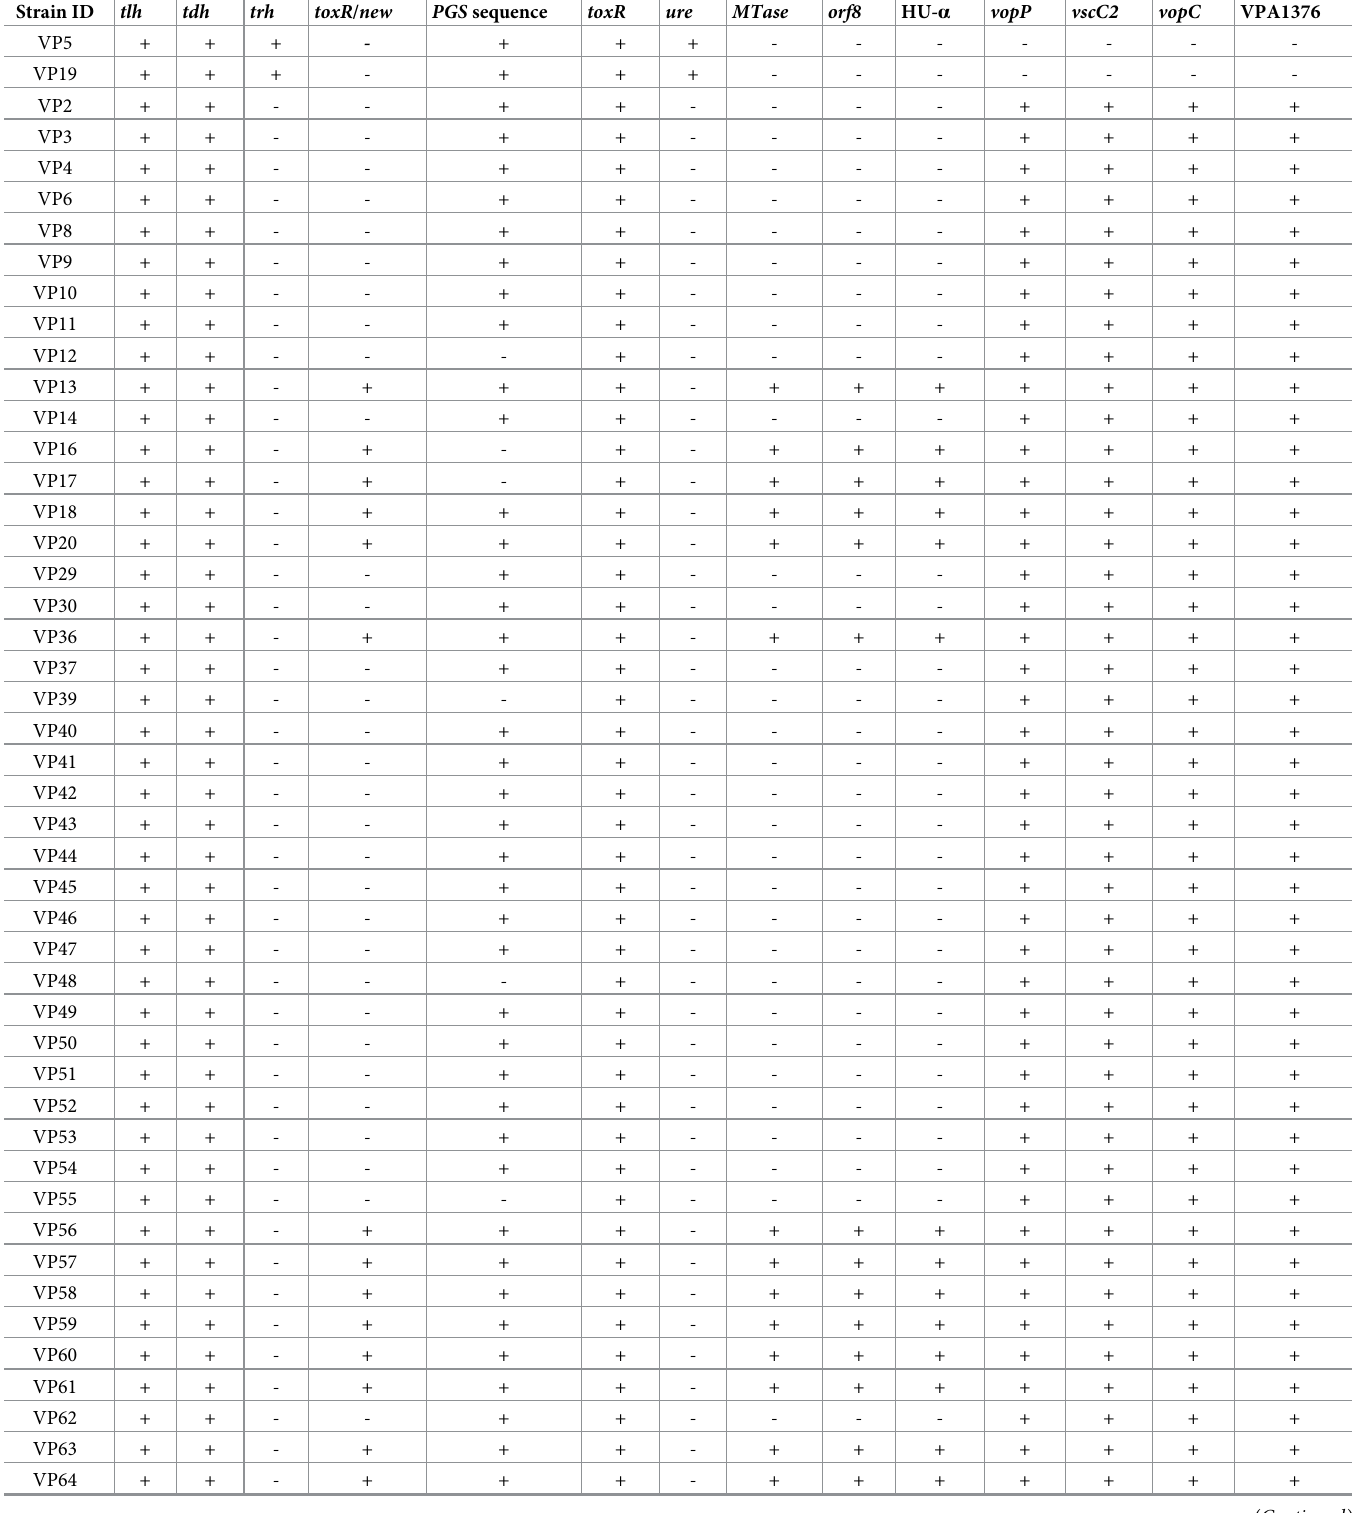
Table 2. Presence of virulence genes in the 66 clinical V . parahaemolyticus isolates. Strain